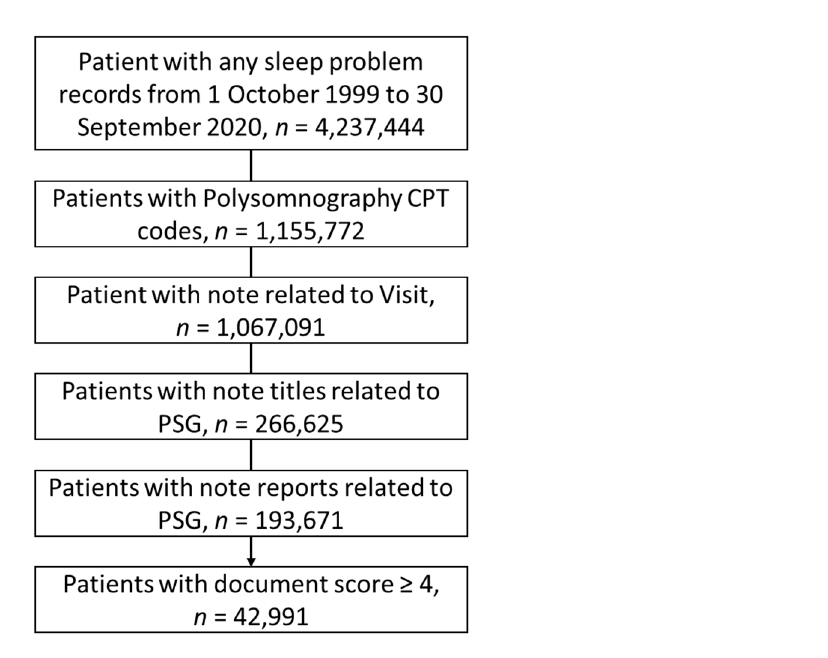
Figure 2. The strobe diagram for collecting patients’ polysomnography reports with CPT codes of ‘95810’, and ‘95811’ who visited veteran health administration (VHA) from 1 October 1999 to 30